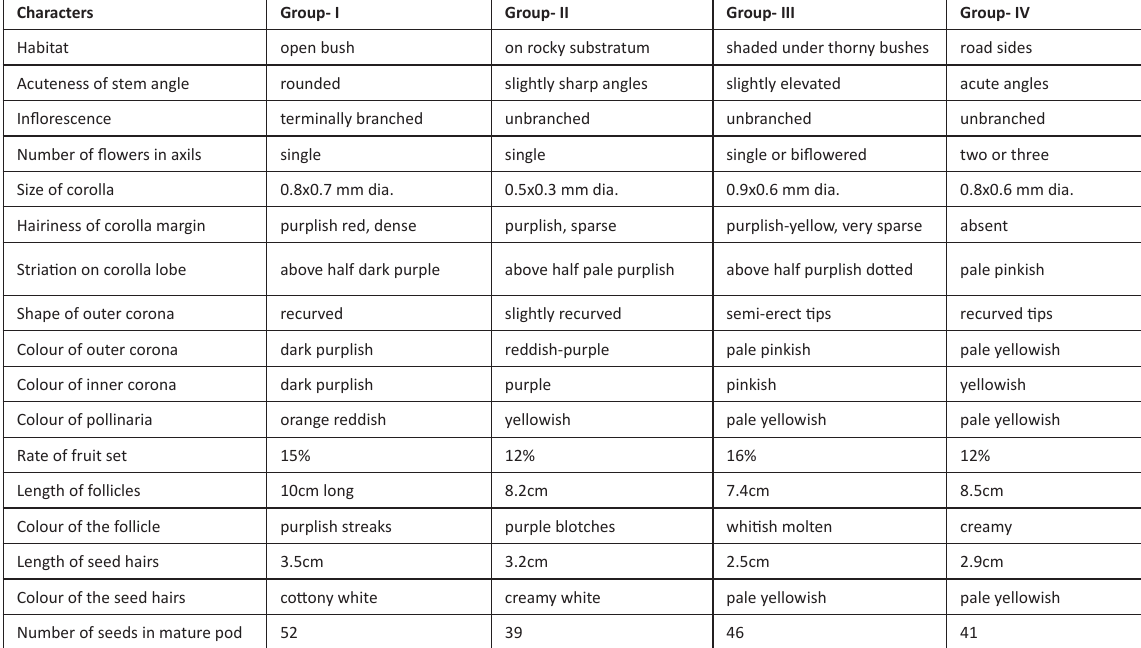
Table 2. Vegetative and reproductive variations in Caralluma adscendens var. attenuata (Wight) Grav. & Mayur. in Tamil